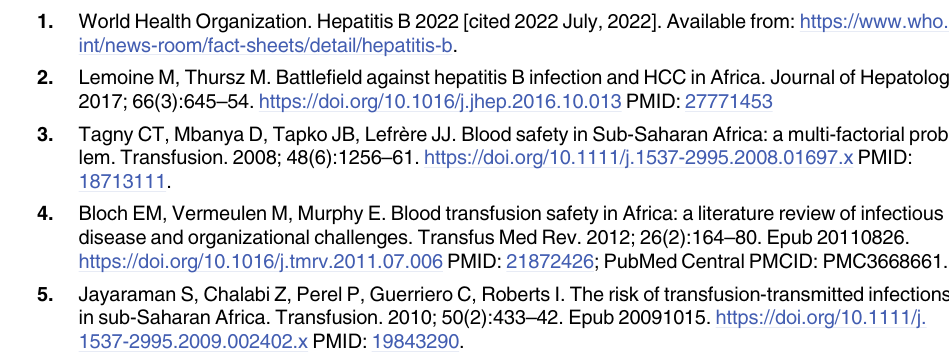
S1 Table. PCR positive samples had an average length of 2208 nucleotides and produced an average of 1,063,988